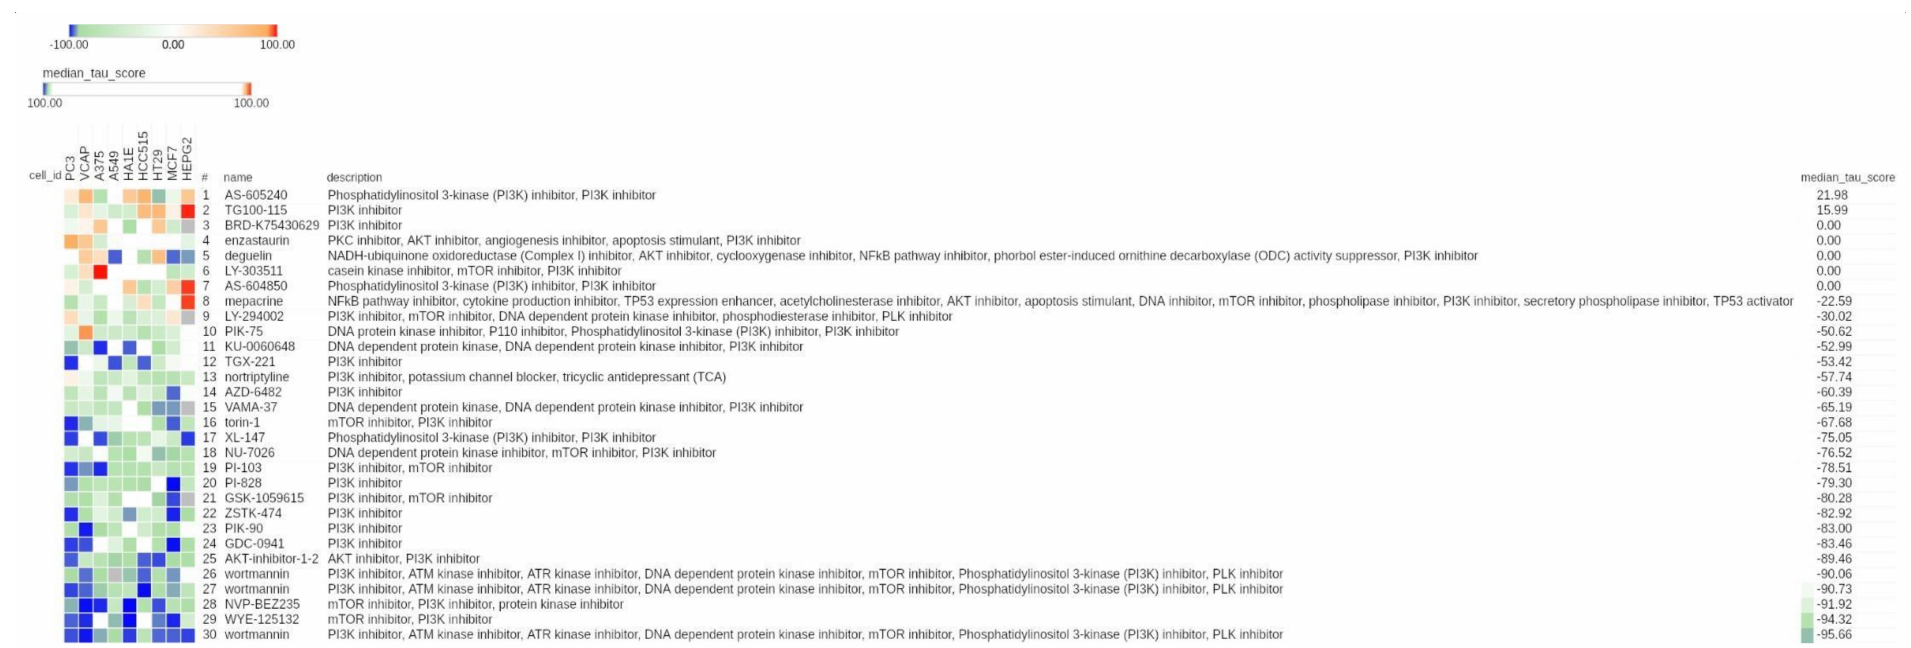
Figure 3. CMap results related to PI3K inhibitors in the entire CMap reference database. Heat map showing the connectivity score between each cell line (columns) and compound (rows). The heat map was generated using the CMap tool. Compounds are relative to the class of PI3K inhibitors. The numeric identifier, compound name, description, and median tau score for each compound are indicated. The cell line identifier is shown on top of the figure. The median tau score measures the strength of connection between a query signature and a drug across multiple cell types. Compounds are sorted by decreasing order of median tau score. Color keys are displayed on top of the